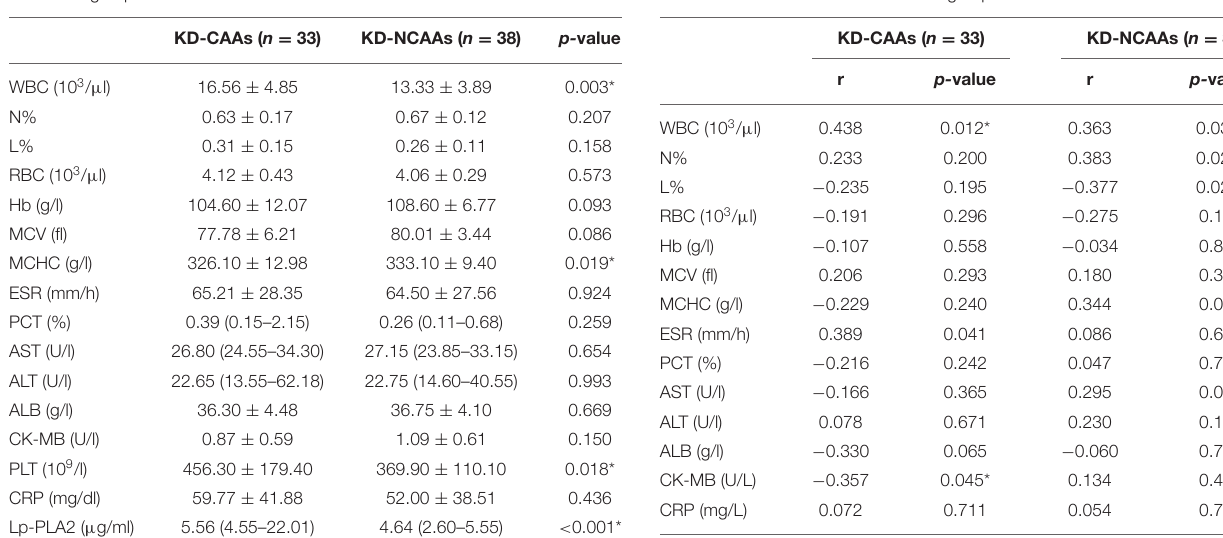
TABLE 1 | General laboratory variables and serum Lp-PLA2 levels in KD-CAA and KD-NCAA groups.